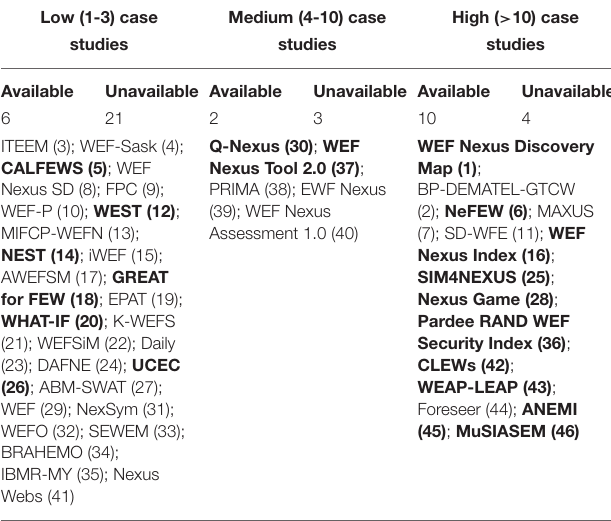
TABLE 7 | WEF nexus tools, ready availability and their case